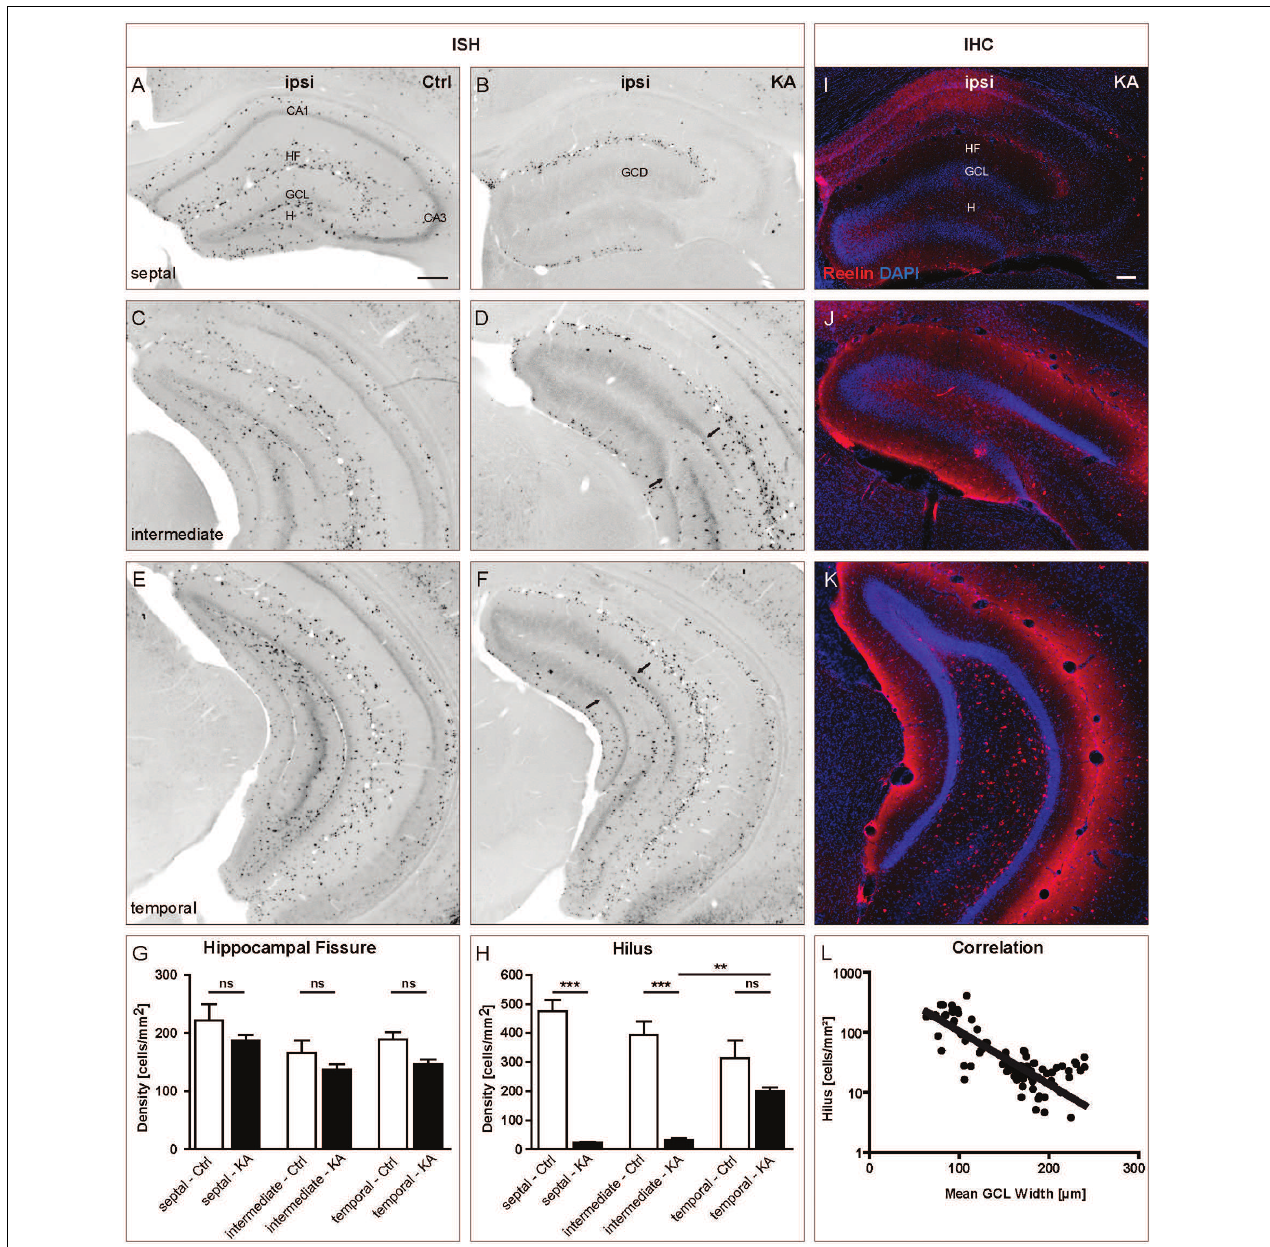
FIGURE 1 | Loss of reelin mRNA-expressing neurons coincides with GCD formation after unilateral intrahippocampal KA injection in adult mice. ISH for reelin mRNA was performed on tissue sections along the septotemporal axis at 21 days after KA injection. (A–F) Representative images showing the distribution of reelin mRNA-positive neurons in sections of the septal (A , B) , intermediate (C , D) and temporal (E , F) portions of the hippocampus of control animals (A , C , E) and ipsilateral to the KA injection (B , D , F) . (A,C,E) In controls, many reelin mRNA-expressing neurons are present in the stratum oriens , stratum lacunosum moleculare , along the HF and in the hilus at all three positions along the septotemporal axis of the hippocampus (septal, intermediate, and temporal). (B) At 21 days after intrahippocampal KA injection there is a drastic loss of reelin mRNA-expressing neurons all over the ipsilateral septal hippocampus, where GCD is present. Only at the HF, they are preserved. (D,F) A loss of reelin mRNA-positive neurons can also be observed in intermediate and temporal sections, however, being confined to the portion with GCD. Arrows indicate the transition from GCD to normal GCL, where reelin mRNA-positive neurons reappear. (G,H) Quantification of the number of reelin mRNA-expressing neurons in the HF (G) and the hilus (H) in controls ( n = 3) and after KA injection ( n = 5) at three different positions along the septotemporal axis of the hippocampus (septal, intermediate, and temporal). Note the significant loss of reelin mRNA-expressing neurons in the hilus at septal and intermediate positions. One-way ANOVA followed by Tukey’s Multiple Comparison Test ( ∗∗ P < 0.01; ∗∗∗ P < 0.001). Representative images of tissue sections immunolabeled for Reelin (red) counterstained with DAPI (blue) of the septal (I) , intermediate (J), and temporal (K) portions of the hippocampus ipsilateral to the KA injection. Like on the mRNA level, Reelin-expressing neurons are gone in the septal and intermediate hilus but are preserved at the HF. They reappear in the temporal hippocampus, mirroring the distribution of reelin mRNA expression. (L) Graph showing the correlation of the mean GCL width with the number of reelin mRNA-positive hilar neurons ( r 2 = 0.6112). CA1, cornu ammonis 1; CA3, cornu ammonis 3; HF, hippocampal fissure; GCL, granule cell layer; H, hilus; ML, molecular layer. Scale bars: 200 µ m.